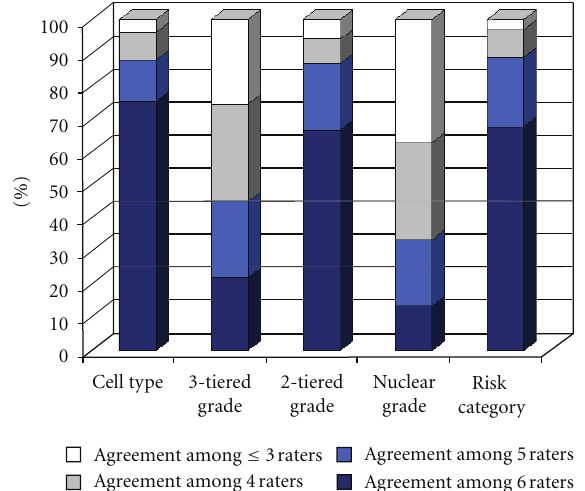
Figure 1: Percentage of cases by degree of agreement in each